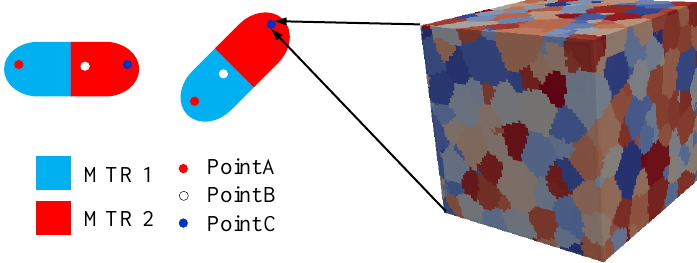
Figure 3. Description of microscale model of α particles within MTR subjected to strain path from individual finite elements at mesoscale; input texture contains fiber texture about mesoscale c -axis.